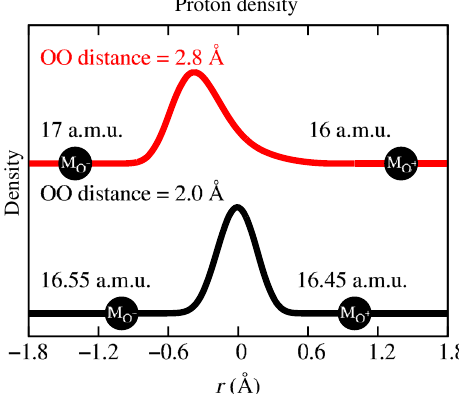
FIG. 4. Proton density at two values of the O ─ O distance (2.0 Å black and 2.8 Å red), where the masses of the oxygens (sum of columns of the matrix M , see text) M A matrix effect.